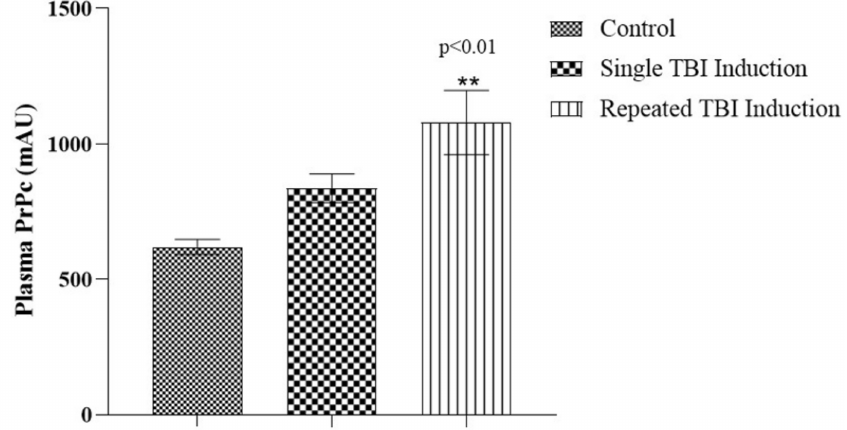
Figure 4. Plasma PrPc levels in TBI mice following single and repeated TBI induction. Bar diagram represents the level of PrPc in plasma (mAU); values are expressed as mean ± SEM; n = 6; mean differences between the groups were analyzed using one way ANOVA followed by Tukey’s multiple comparison test as post hoc in Graphpad prism software (v 8.0); ** indicate p < 0.01 vs. control mice.